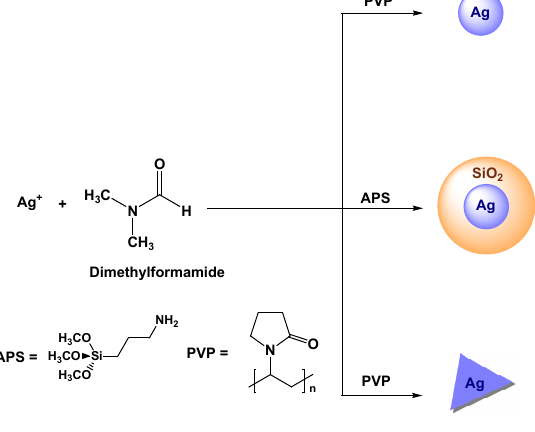
Figure 4. Synthesis of Ag NPs using DMF as reducing agent. When PVP is used as nanospheres (up) or nanoprisms (bottom) can be obtained. When APS is used silver nanoparticles with a SiO shell are obtained. 2